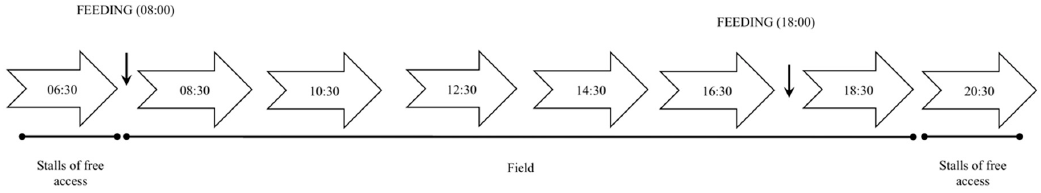
Figure 1. Saliva sampling scheme for the circadian rhythmic study.